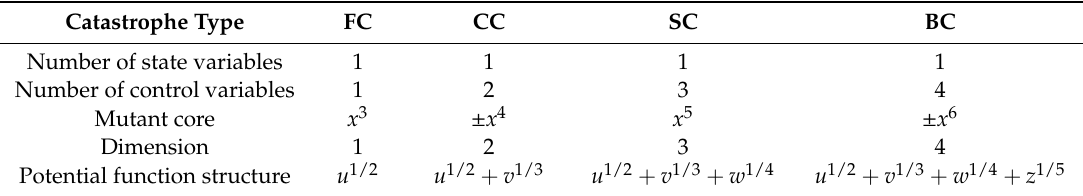
Table 2. Catastrophe type functions. Fold catastrophe (FC), cusp catastrophe (CC), swallowtail catastrophe (SC), and butterfly catastrophe